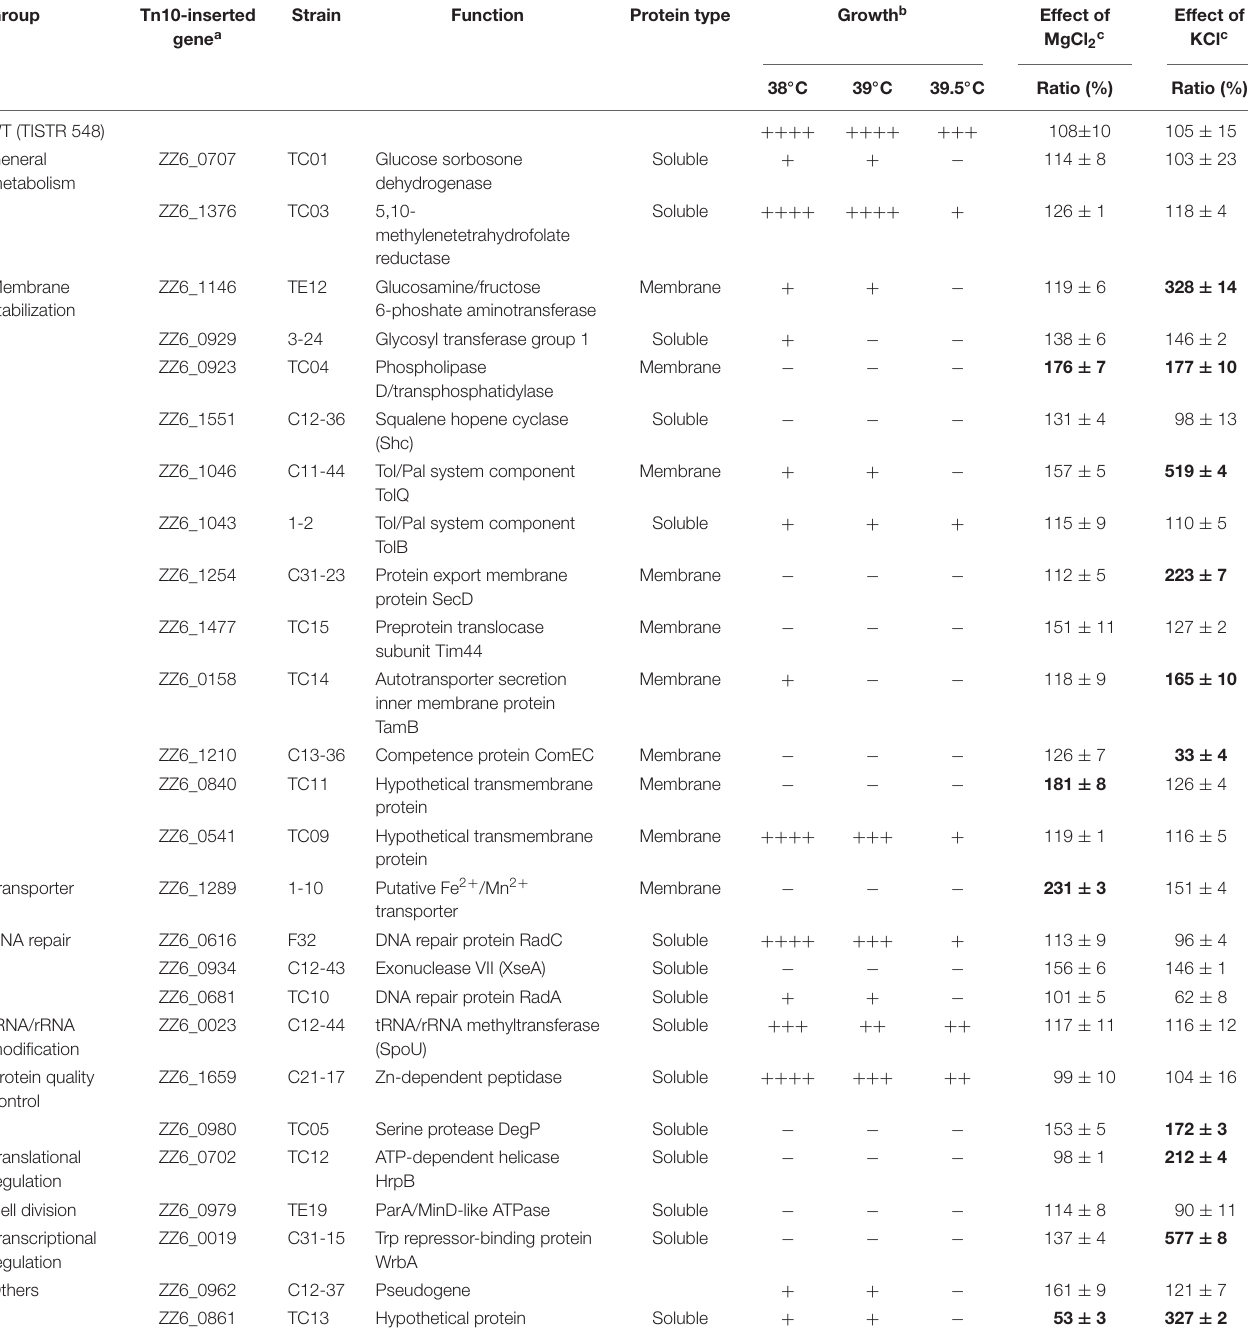
TABLE 2 | Effects of Mg 2 + and K + on the growth of thermosensitive mutants from Zymomonas mobilis TISTR 548.